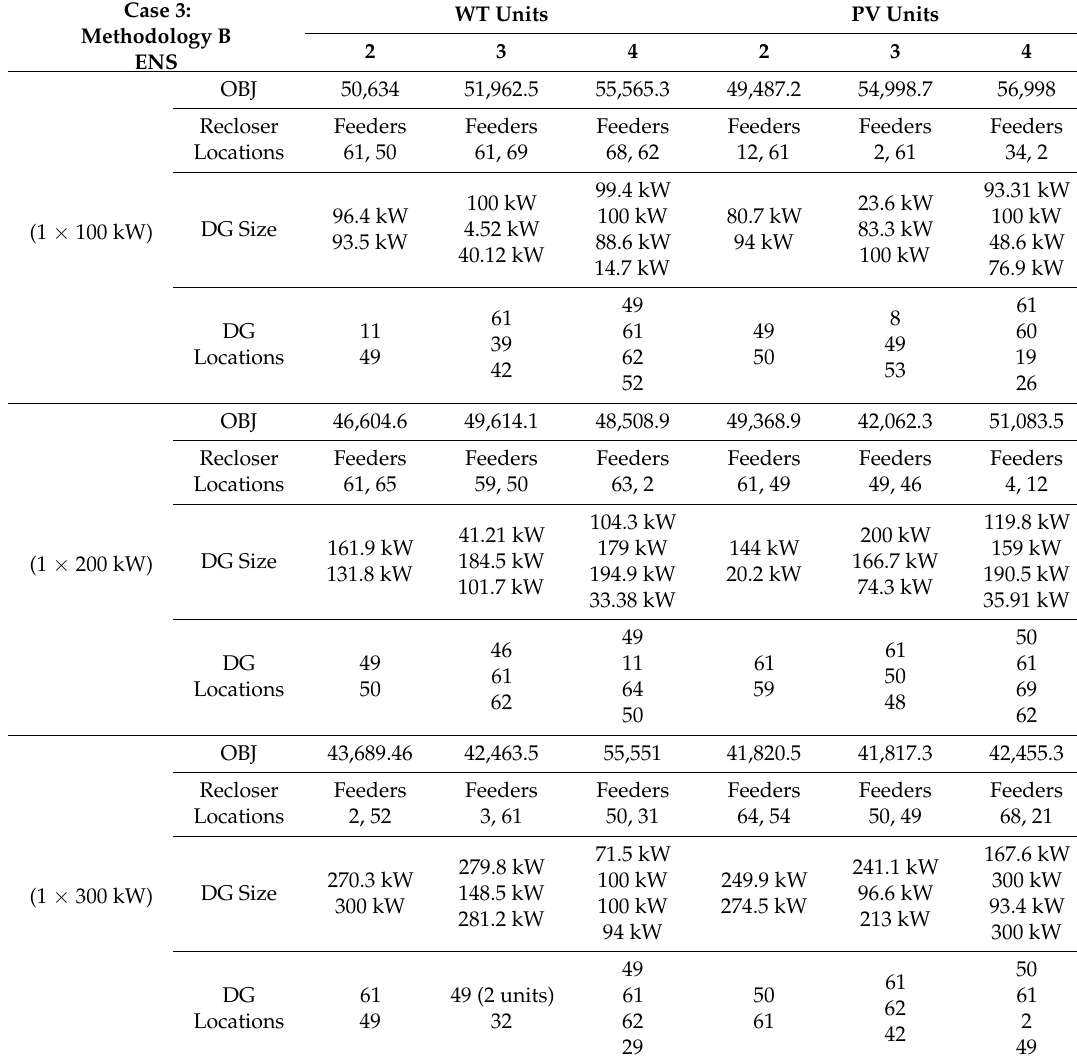
Table 8. System indices indicating the effect of DG units